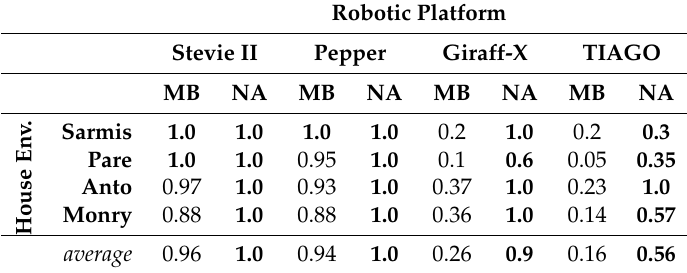
Table 1. Results of the simulated experiment for the different robots and house environments. For each combination, the navigation success rate (NSR) when employing standard navigation algorithms based on the widely employed ROS move_base stack (MB), and when using the proposed navigation assistant are depicted. Average values are also included. Values in bold represent the best NSR for each